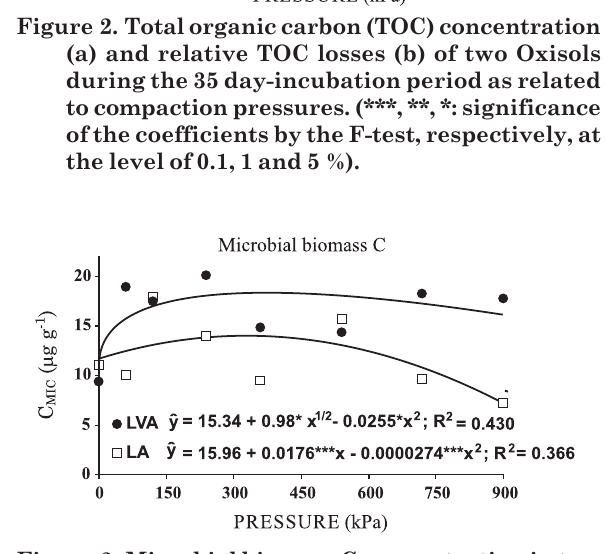
Figure 3. Microbial biomass C concentration in two Oxisols subjected to increasing compaction pressures. (***, **, *: significance of the coefficients by the F-test, respectively, at the level of 0.1, 1 and 5 %).